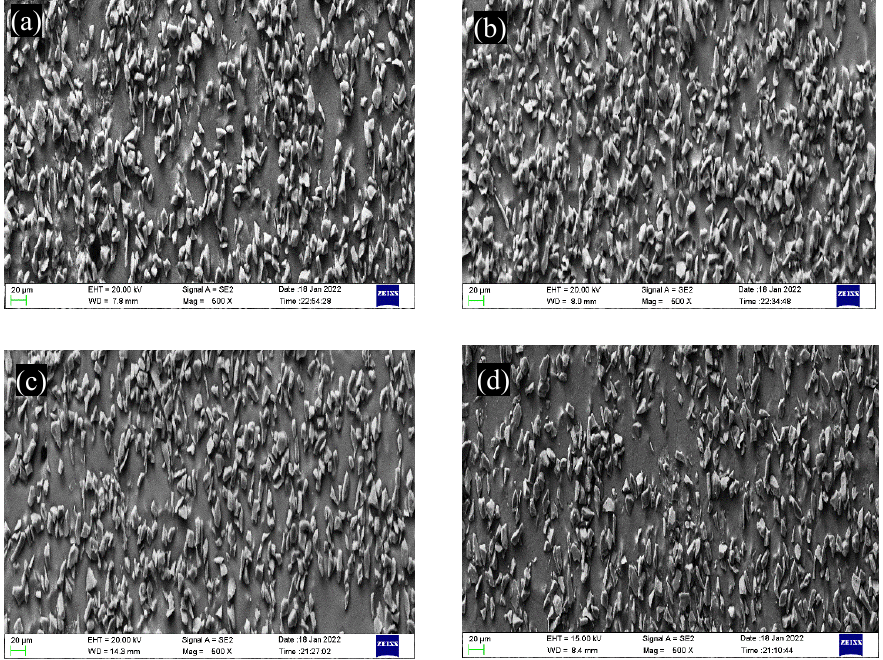
Figure 4. SEM images showing 500 times SiC p /AZ91D composite particle distribution. ( a ) 0 A; ( b ) 400 A; ( c ) 800 A; ( d ) 1200 A.